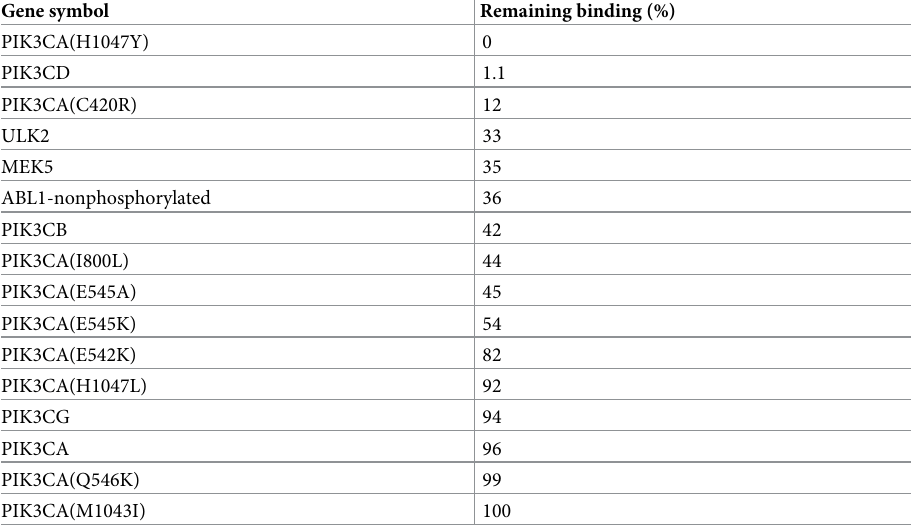
Table 2. CPL302-253 interactions with human kinome. CPL302-253 binding to a human kinome was assessed in KINOMEScan assay at 1 μ M. The numbers represent % of the remaining binding of specific ligand to kinase in com- petitive binding assay with CPL302-253. The table includes targets with remaining binding lower than 40% and PI3K